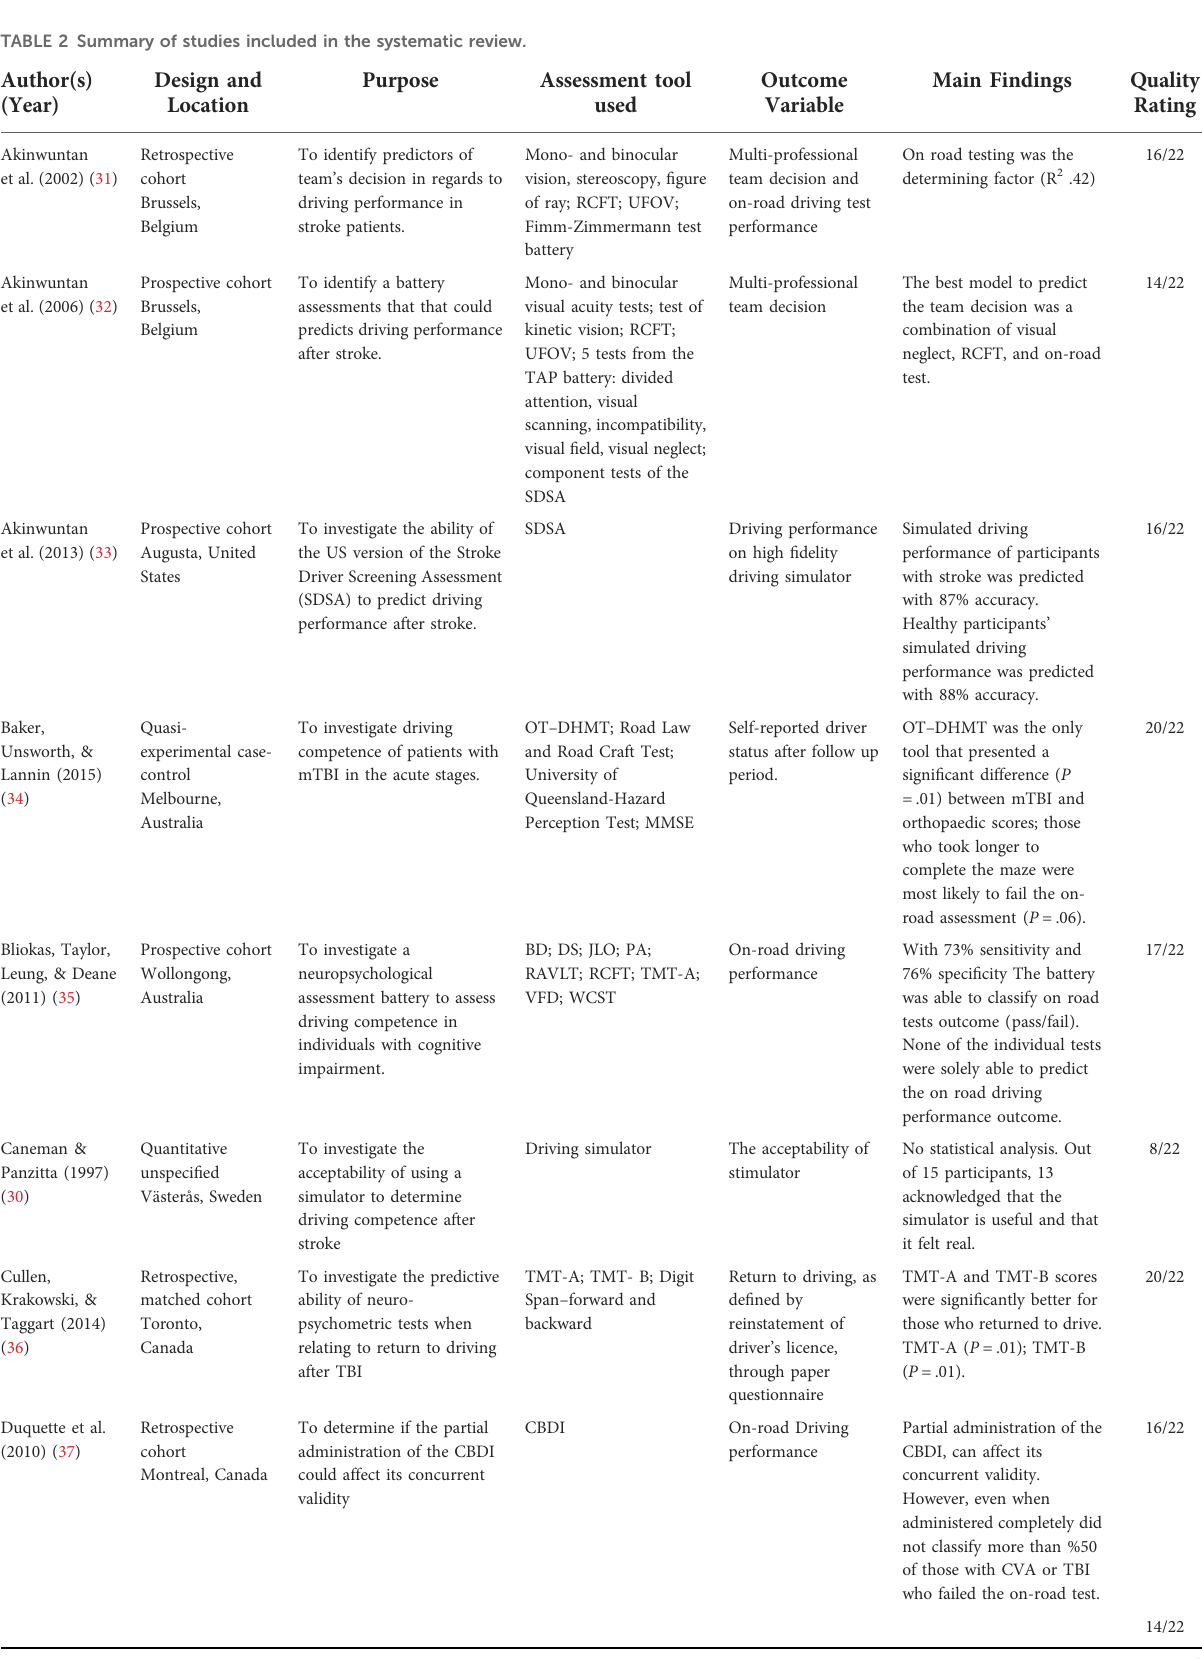
TABLE 2 Summary of studies included in the systematic